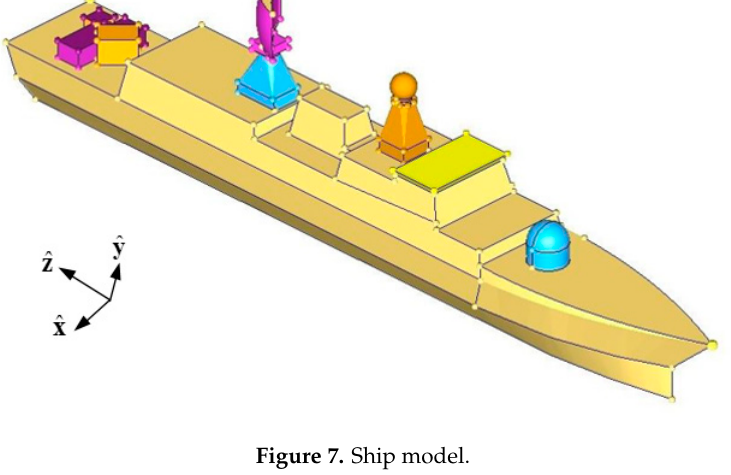
Figure 7. Ship model. Sensors 2018 , 18 , x FOR PEER REVIEW